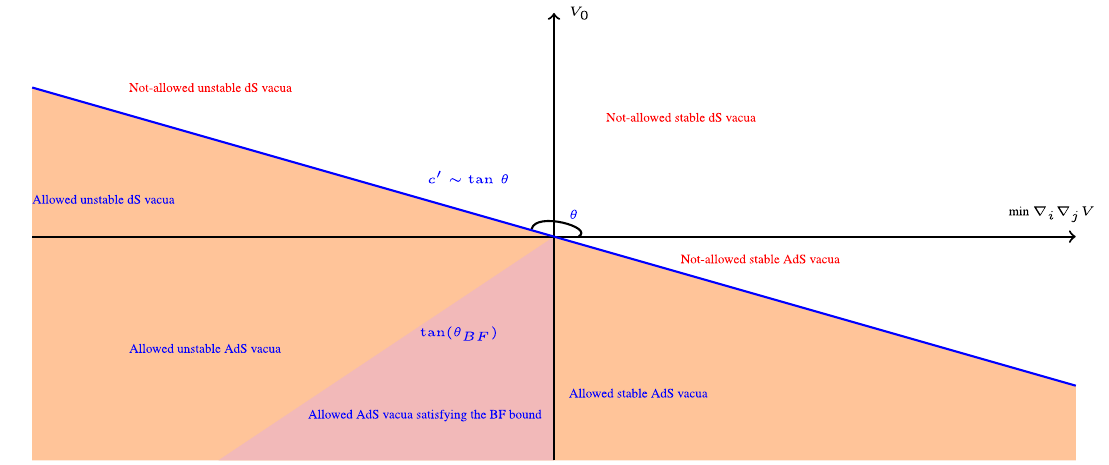
Fig. 1 Agreement of given effective model with the refined de Sit- ter conjecture defines 6 different zones. Three of them belong to the Swampland.Theangle θ definestheslopeofthelinedividingtheregions